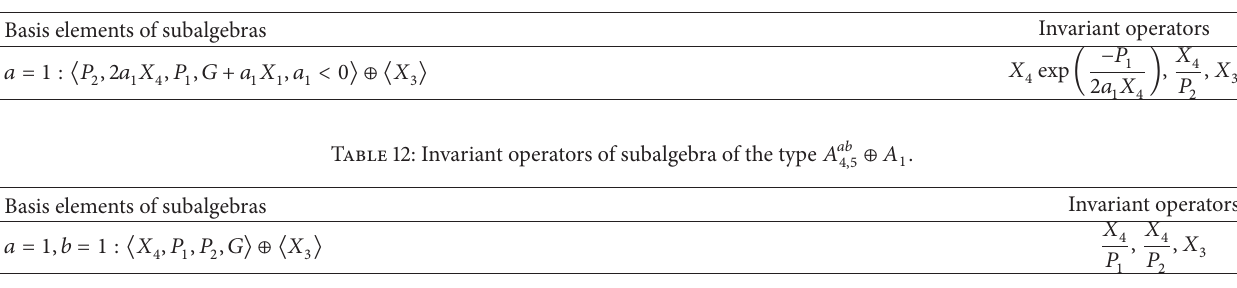
Table 11: Invariant operators of subalgebras of the type 𝐴 𝑎 4,2 ⊕ 𝐴 1 .